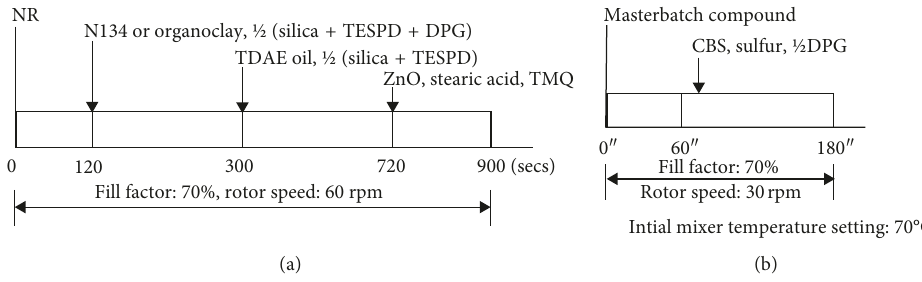
Figure 1: Two-step mixing procedure for preparing the compounds in this study. (a) First step. (b) Second